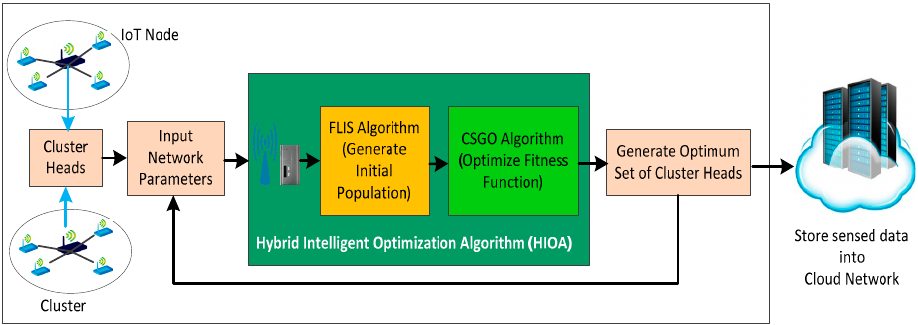
Figure 1. Block diagram of HIOA.